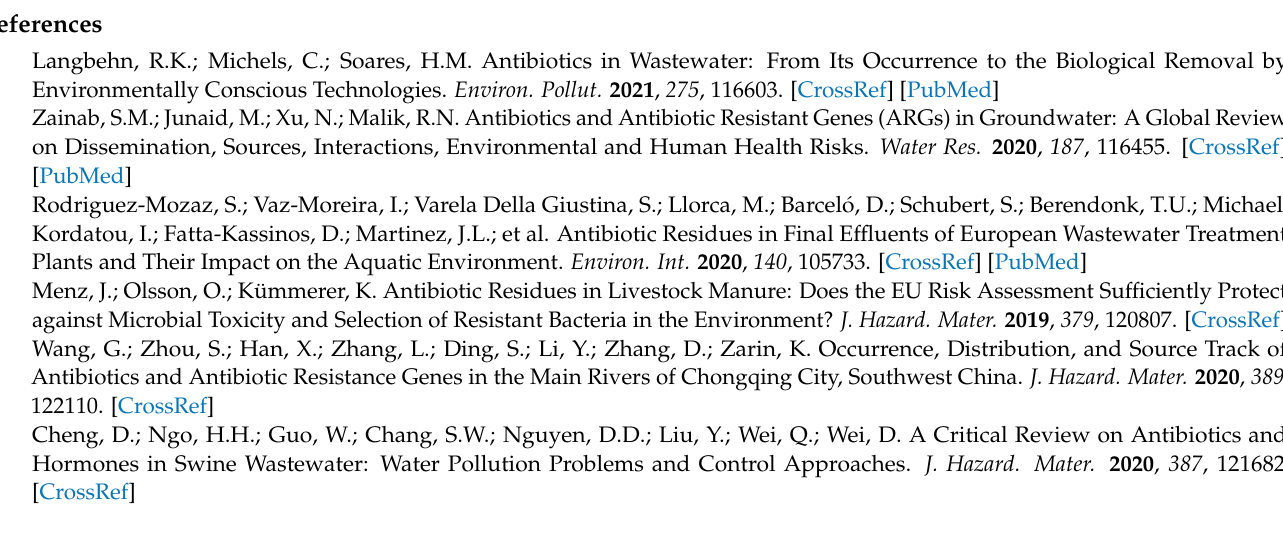
Table S2: HPLC working conditions for quantification of the target antibiotics; Table S3: PNECs of the detected antibiotics for different living organisms in waters; Table S4: Average recoveries, limit of detection (LOD), and limit of quantification (LOQ) of seventeen target antibiot-ics for wastewa- ter